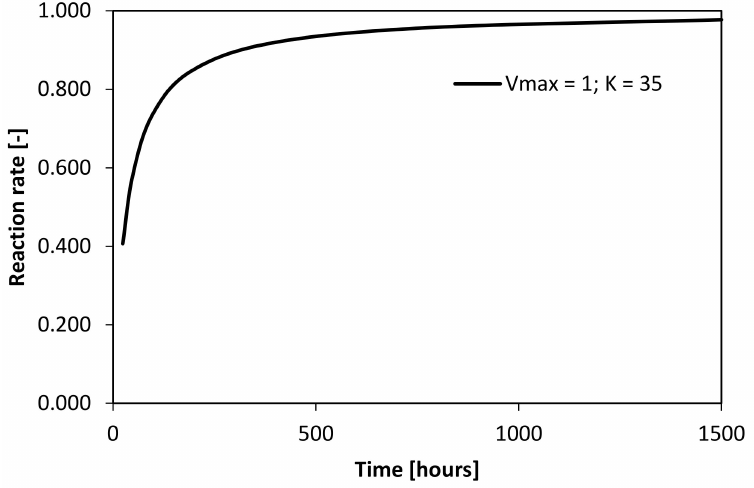
Figure 3. Illustration of Michaelis-Menten